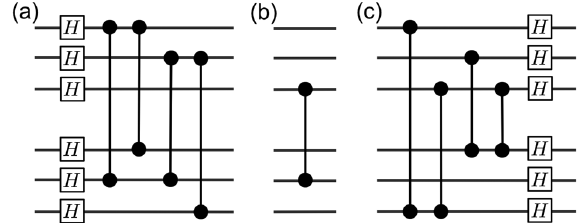
FIG. 6. A pieceable implementation of CZ on Shor ’ s 9-qubit code using three pieces (a) – (c). Only active qubits, namely, 1, 2, 3 from each code block, are shown. Since the circuit is Clifford, intermediate error correction consists of standard Pauli measure- ments.